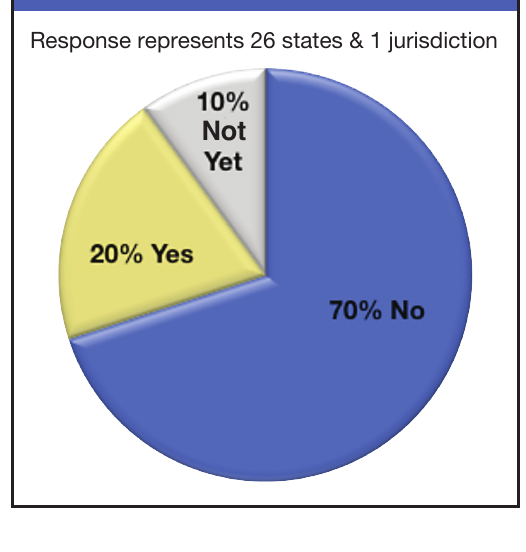
Figure 1: Percentage of states and jurisdictions reporting utilization of telehealth in EI programs Is your state currently delivering any Part C services via